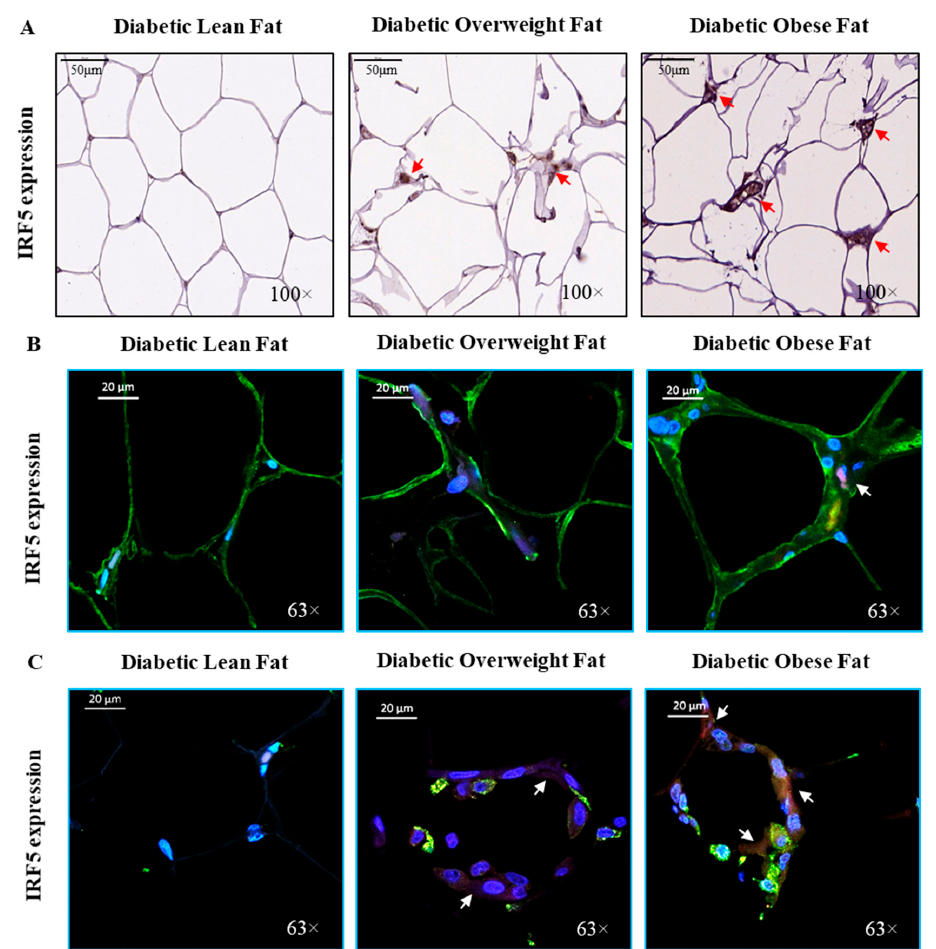
Figure 2. Comparative adipose tissue IRF5 expression in diabetic patients. Adipose IRF5 protein